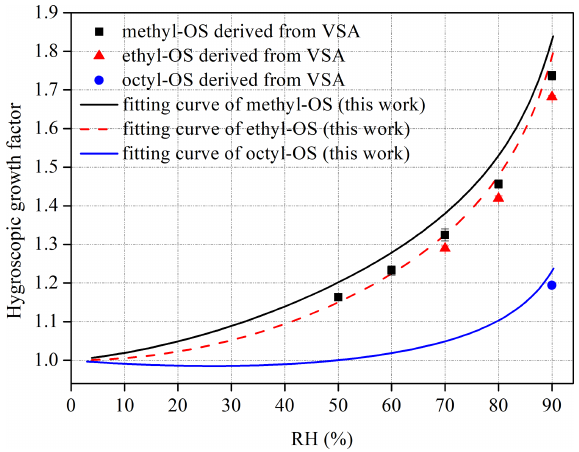
Figure 6. Comparison between hygroscopic GFs of methyl-, ethyl- and octyl-OS derived from VSA experiments to those measured us- ing H-TDMA. Please note that H-TDMA results are presented as the three parameter curves obtained. Error bars are included, but they are too small to be clearly